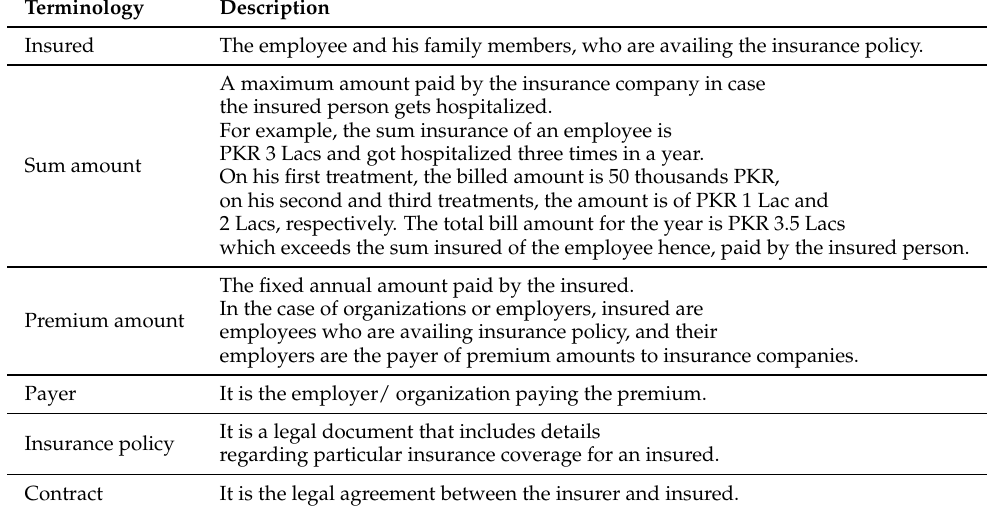
Table 1. Important